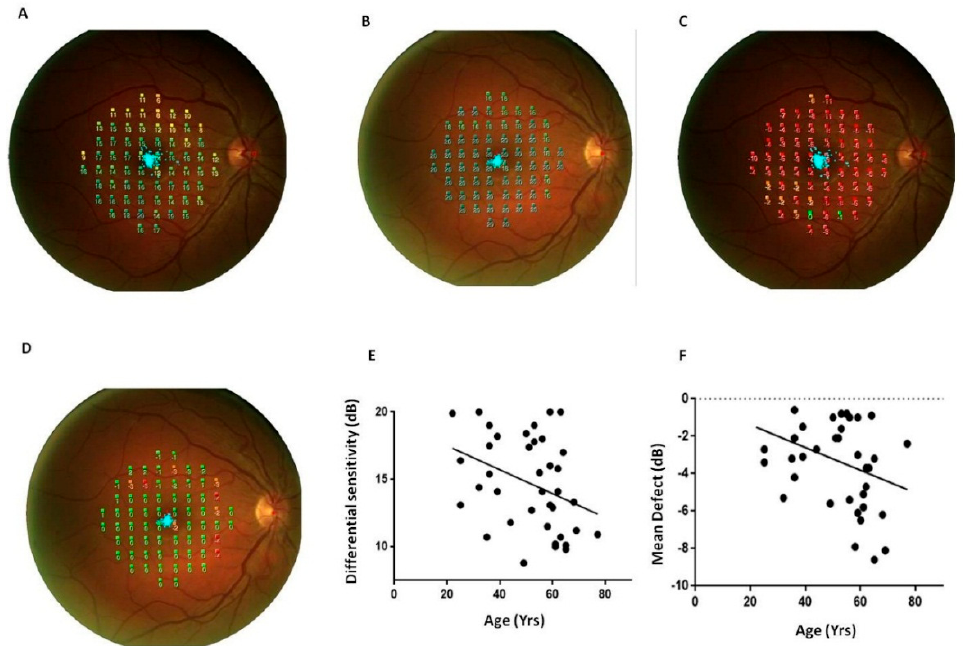
Figure 3. Fundus perimetry in patients with psoriatic arthritis sine psoriasis . FP, Fundus Perimetry; PsA, Psoriatic arthritis; HC, healthy control. Representative scans of the retinal differential light sensitivity and mean defect of the posterior pole were reported from a PsA patient (panels ( A ) and ( C )) and a sex/age-matched HC (panels ( B ) and ( D )). Panels ( E , F ): Differential light sensitivity and mean defect resulted related with the age (r = − 0.4, p = 0.03, for both the correlations). The significance of any correlation was determined by Pearson correlation test or Spearman’s rank correlation coefficient where appropriate. P values < 0.05 were considered significant.